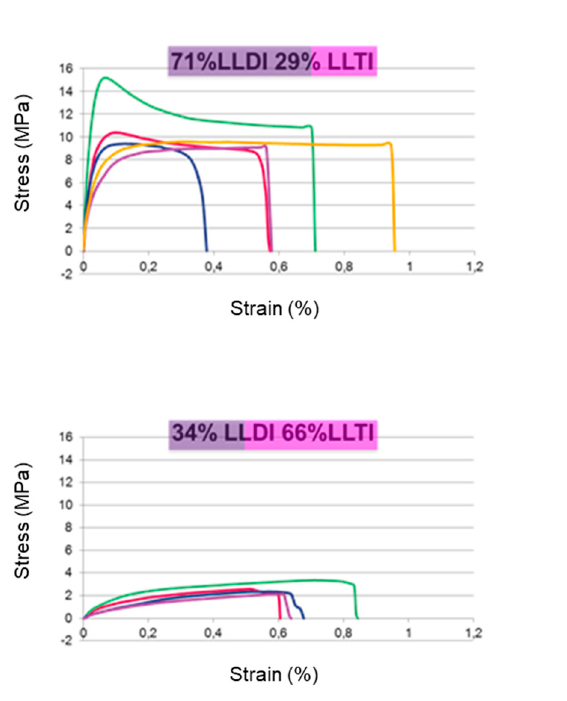
Figure 4. Stress–strain behavior of PUs with different LLDI/LLTI ratios.